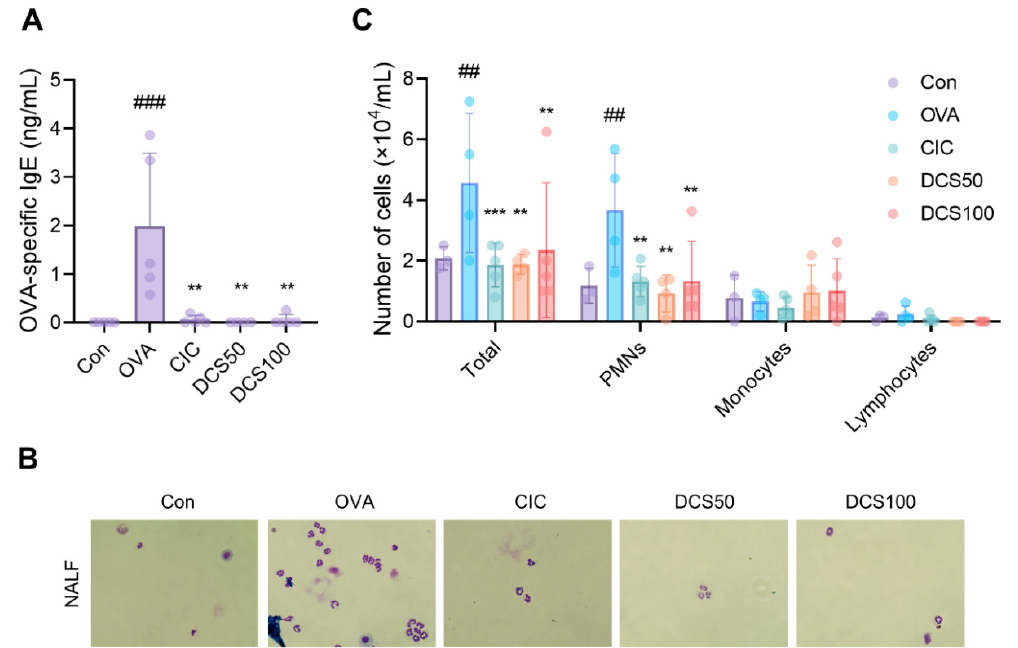
Figure 9. N,N (cid:48) -dicoumaroylspermidine reduced the amount of OVA-specific IgE in serum, as well as infiltration of NAL by polymorphonuclear leukocytes. Mice in the CIC, DCS50, and DCS100 groups were sensitized and challenged with OVA prior to nasal administration of 15 µ g of CIC, 50 µ g of DCS, and 100 µ g of DCS, respectively. ( A ) The amount of OVA-specific IgE in serum was measured in an ELISA. ( B ) Cytospin cell preparations were obtained after staining NALF with Diff-Quik ( × 400). ( C ) Total and individual cell numbers were counted using a hemocytometer. Data are expressed as the mean ± SD ( n = 5 per group). ## p < 0.01, ### p < 0.001 versus the control group. ** p < 0.01, *** p < 0.001 versus the ovalbumin group. Con, control; OVA, ovalbumin; CIC, ciclesonide; DCS, N,N (cid:48) -dicoumaroylspermidine; PMNs, polymorphonuclear